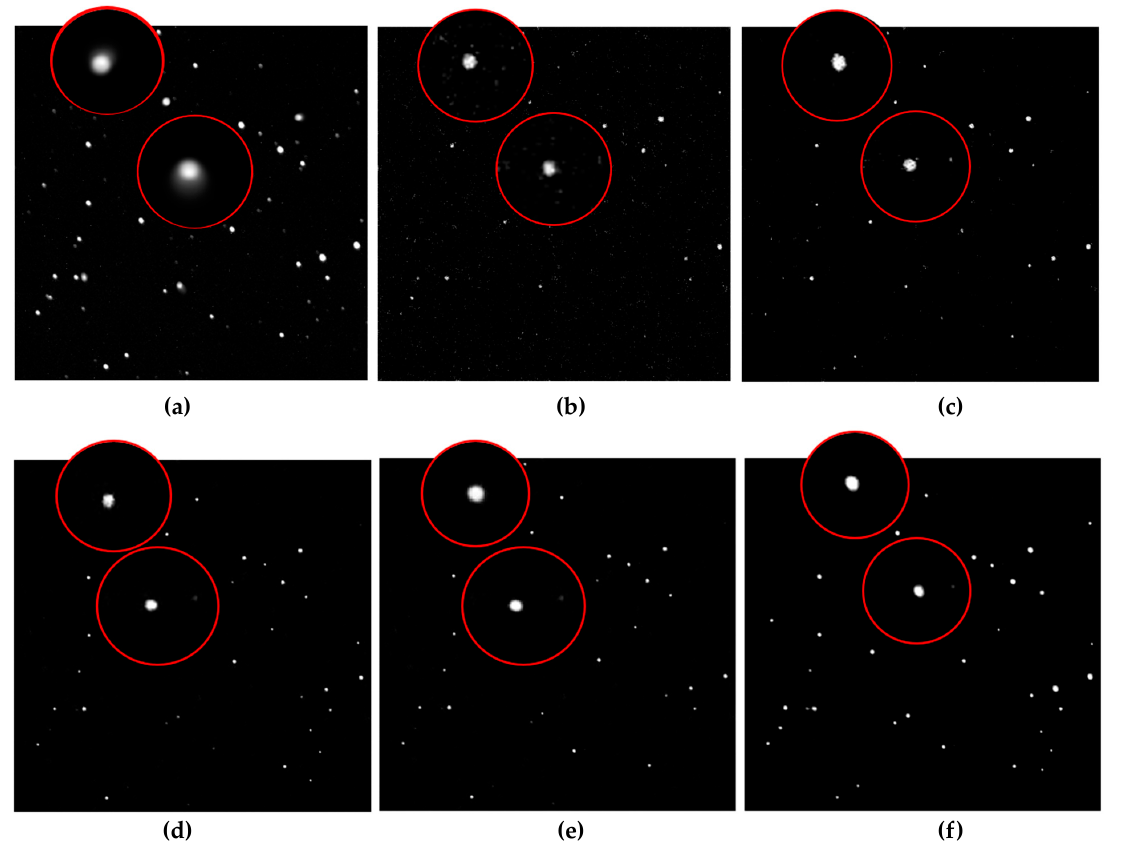
Figure 10. ( a ) The original image. ( b ) Images restored when using encoder–decoder; ( c ) images restored when using the basic network; ( d ) images restored when using ASAnet without self-a tt en- tion; ( e ) images restored when using ASAnet without skip connection; ( f ) images restored when using ASANet.